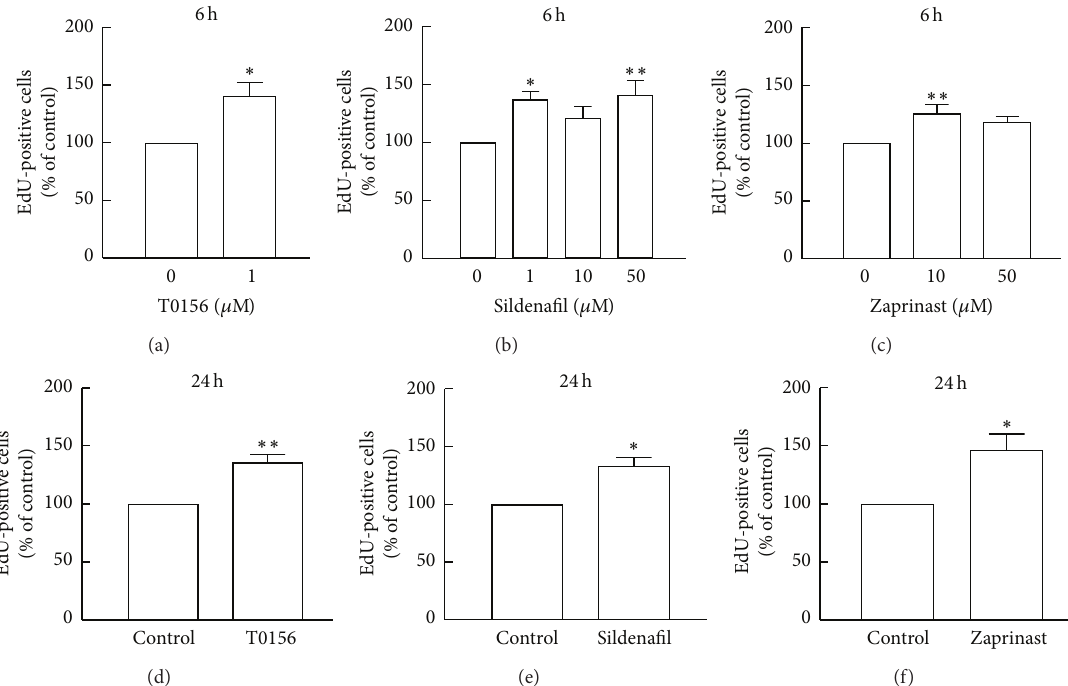
Figure 1: The PDE5 inhibitors T0156, sildenafil, and zaprinast stimulated the proliferation of SVZ neural stem cells following a 6 h or 24 h exposure.Cellsweretreatedwith1 𝜇 MT0156(a),1 𝜇 M,10 𝜇 Mand50 𝜇 Msildenafil(b),or10 𝜇 Mand50 𝜇 Mzaprinast(c)for6 h,andwith1 𝜇 M T0156 (d), 1 𝜇 M sildenafil (e), or 10 𝜇 M zaprinast (f) for 24 h. The incorporation of EdU was assessed by flow cytometry. Data are expressed as means ± SEM of at least 4 independent experiments. (a), (d), (e), and (f) two-tailed 𝑡 -test, ∗ 𝑃 < 0.05 and ∗∗ 𝑃 < 0.01 , significantly different from control and, (b) and (c) one-way ANOVA (Dunnett’s post-test), ∗ 𝑃 < 0.05 and ∗∗ 𝑃 < 0.01 , significantly different from